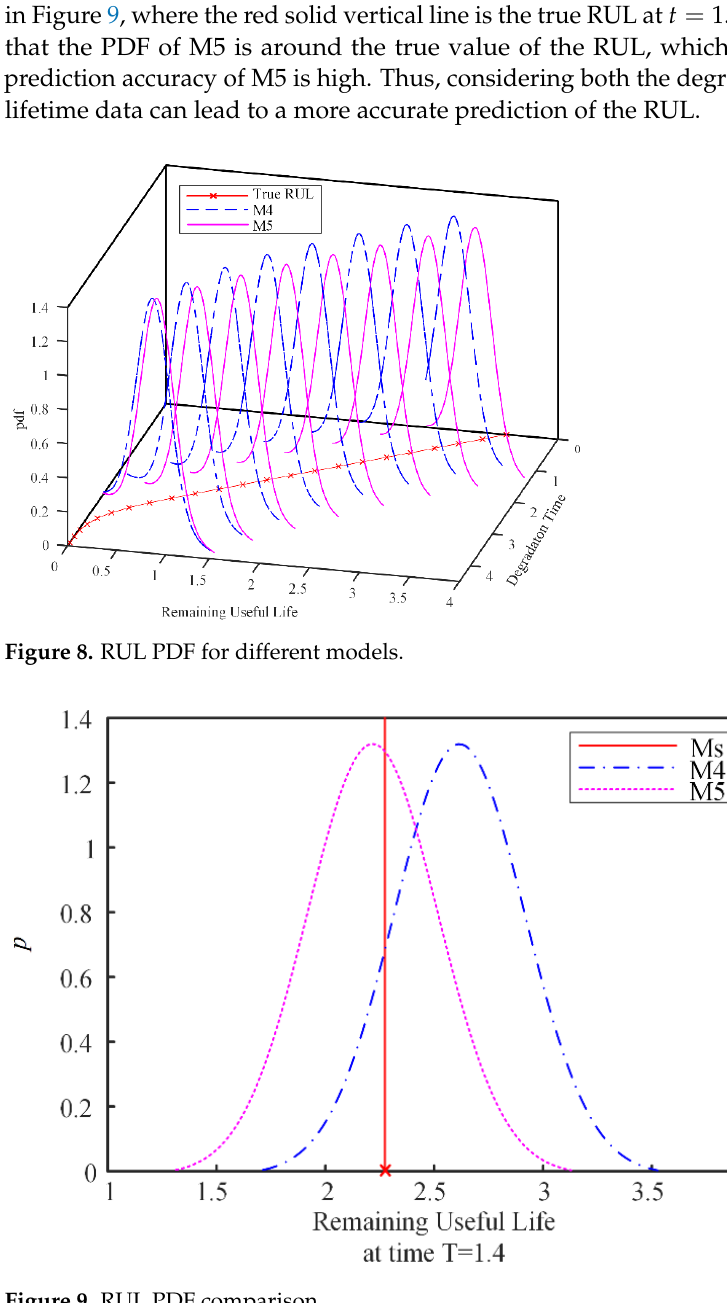
Table 4. MTTF comparison.